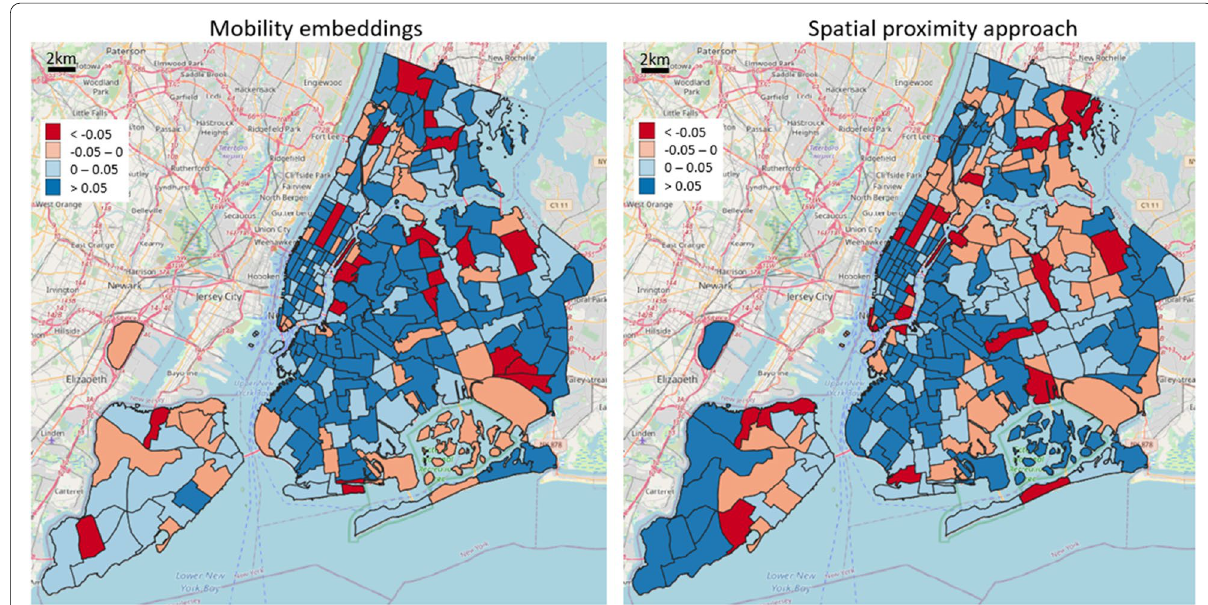
Fig. 11 Assessment of functionality cluster consistency according to different POI-based functionality classes (cater, public facility, shopping, life service, accommodation service): cosine similarity difference between intra- and extra-block averages for each reference